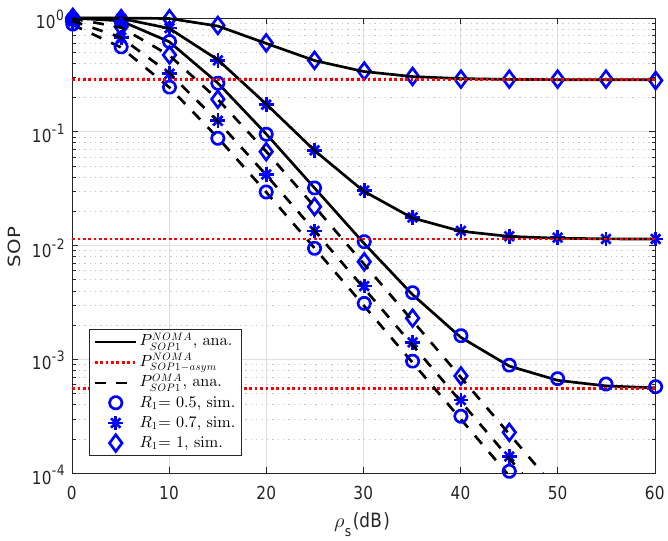
Figure 2. Comparison study on SOP of NOMA and OMA for User D1 versus ρ S = ρ R as changing R 1 ( λ D 1 = λ E = 1, ρ E = 0 dB, R 2 = 1).